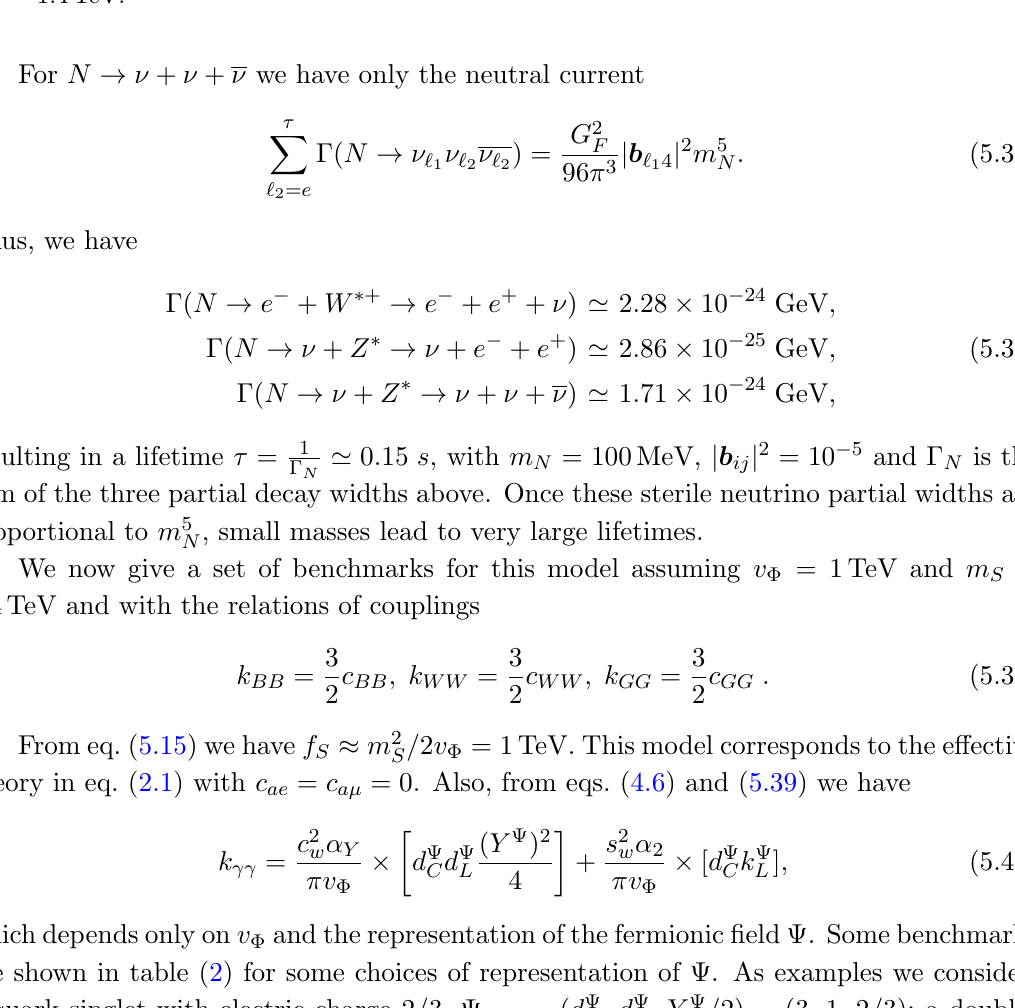
Table 2 . Benchmarks for a quark singlet, doublet and triplet of SU(2) L , assuming v (cid:8) = 1 TeV and m S = 1 : 4